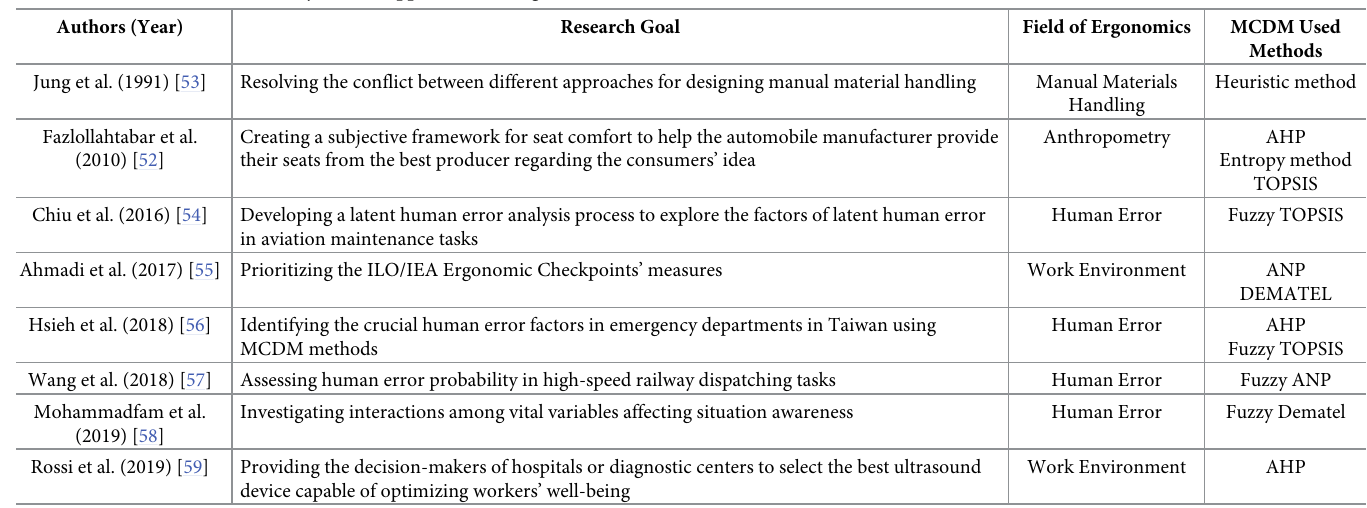
Table 2. Literature review summary MCDM applications in